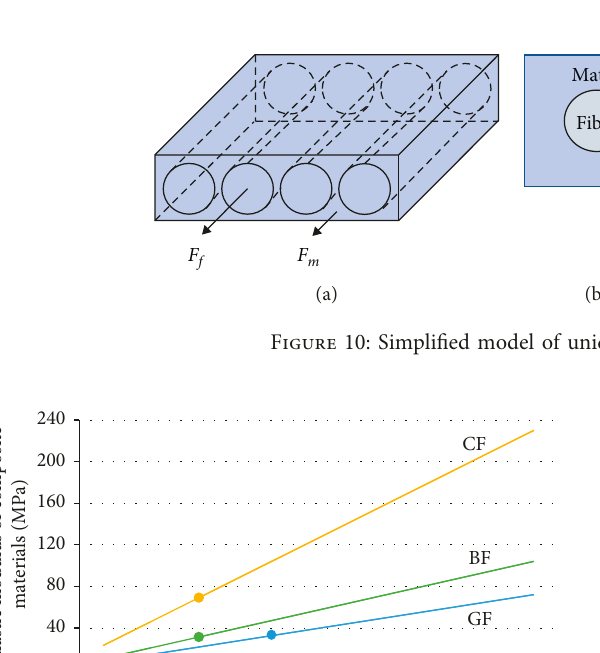
Figure 9: Fatigue test on the plate.